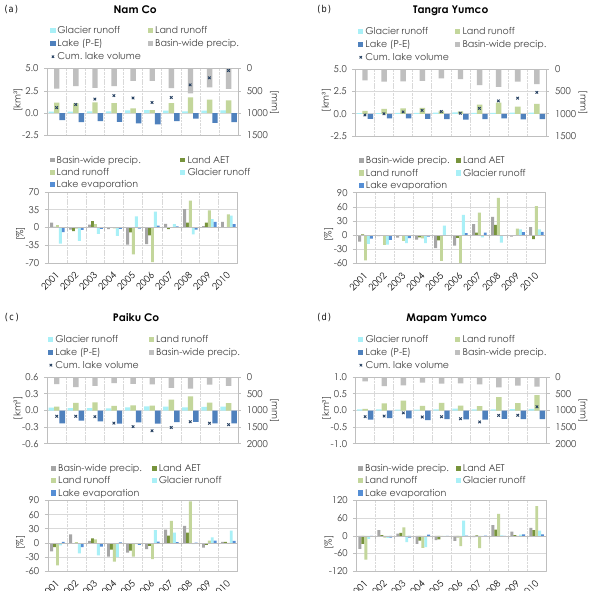
Figure 7. ( a–d , upper panels) Cumulative lake-volume change (km 3 ), contribution of several water-balance components (km 3 ) to lake-volume change and annual basin-wide precipitation amounts (mmyr − 1 ) for the four studied basins. ( a–d , lower panels) Annual percentage deviations from the 10-year average of several water- balance components for the four studied